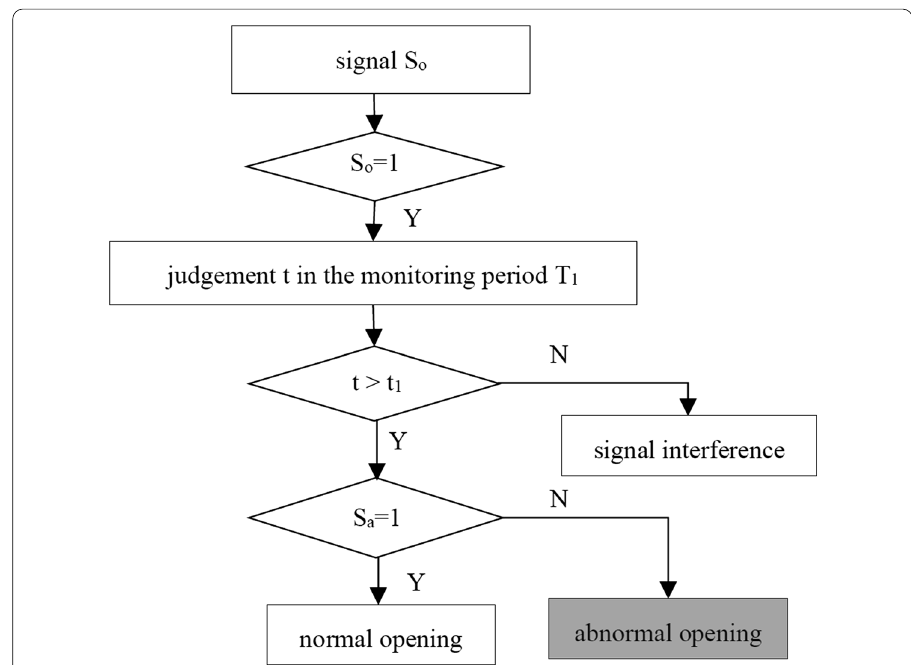
Fig. 4 The judgment method for abnormal opening of the outer manhole cover